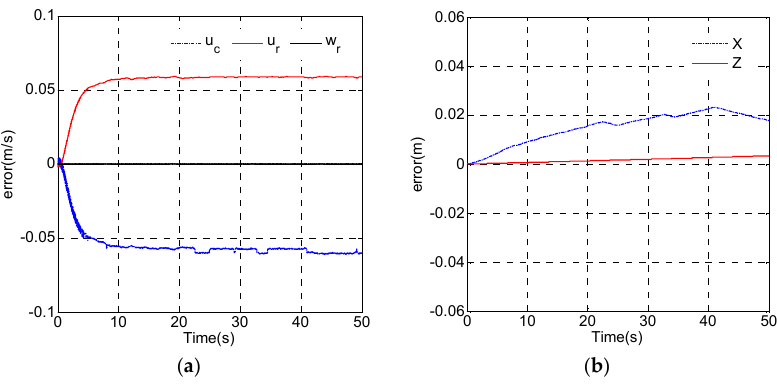
Figure 15. Observed result of ROV position: ( a ) X; ( b ) Z.